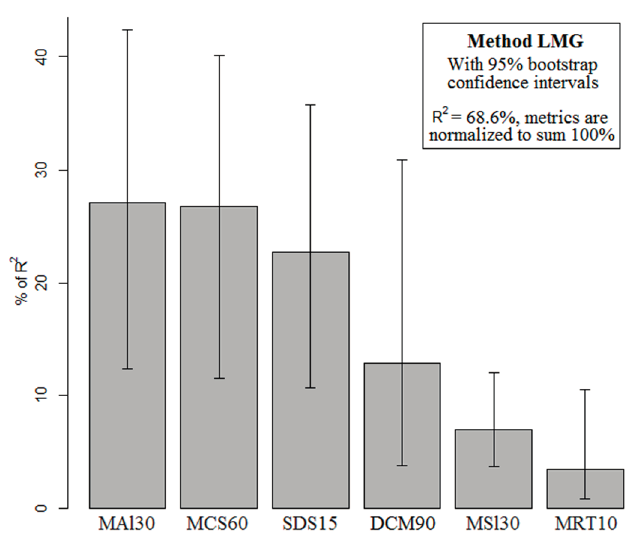
Figure 4. Relative importance of the variables of the model of vascular plant richness based on the percentage of the representation of R 2 obtained by the LMG method [54] The digital crown height model (DCM90), which represents the only forest structural variable, was also of considerable relative importance in the predictive model, which was also found by Dufour et al. [18], Bässler et al. [47], and Féret & Asner [43]. In this sense, the structural